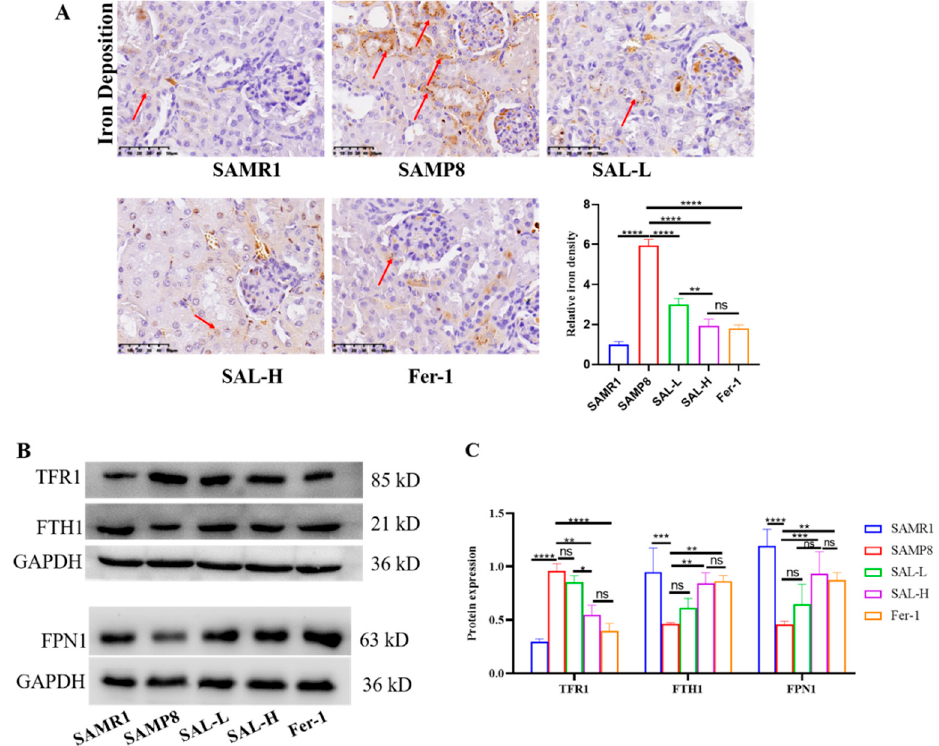
Figure 8 . The effects of SAL on kidney iron deposition and the expression of iron transport-related proteins in SAMP8 mice. ( A ) Kidney iron deposition magnification × 400. ( B , C ) The expression of FTH1, TFR1, and FPN1 proteins in the kidney of SAMP8 mice. Data are expressed as means ± SD, * p < 0.05, ** p < 0.01, *** p < 0.001, **** p < 0.0001.